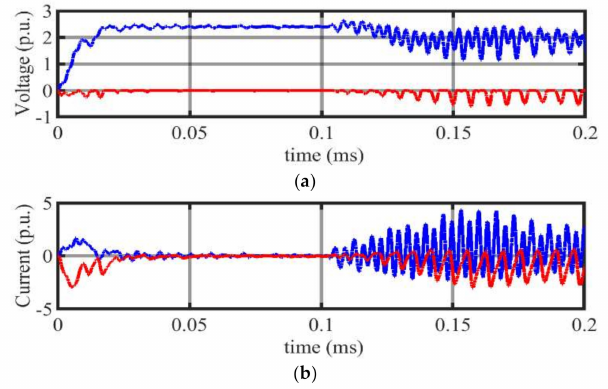
Figure 17. ( a ) DC Voltage and ( b ) DC current profiles at RS-I during NPG fault.